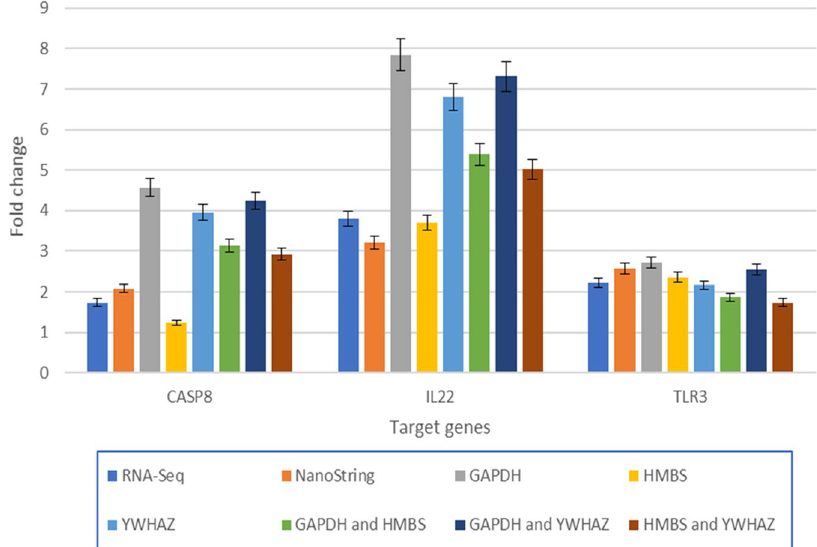
Figure 1. Comparison of RNA-Seq and NanoString results for target genes with RT-qPCR results using different combinations of reference genes. All these differential expression results were generated by comparing chicken IEL-NK cells infected with vvIBDV at 3 days post-infection with cells from uninfected chickens. Results from three biological replicates (n = 3). One biological replicate of each sample consisted of IEL-28.4 + cells harvested from 8 chickens.